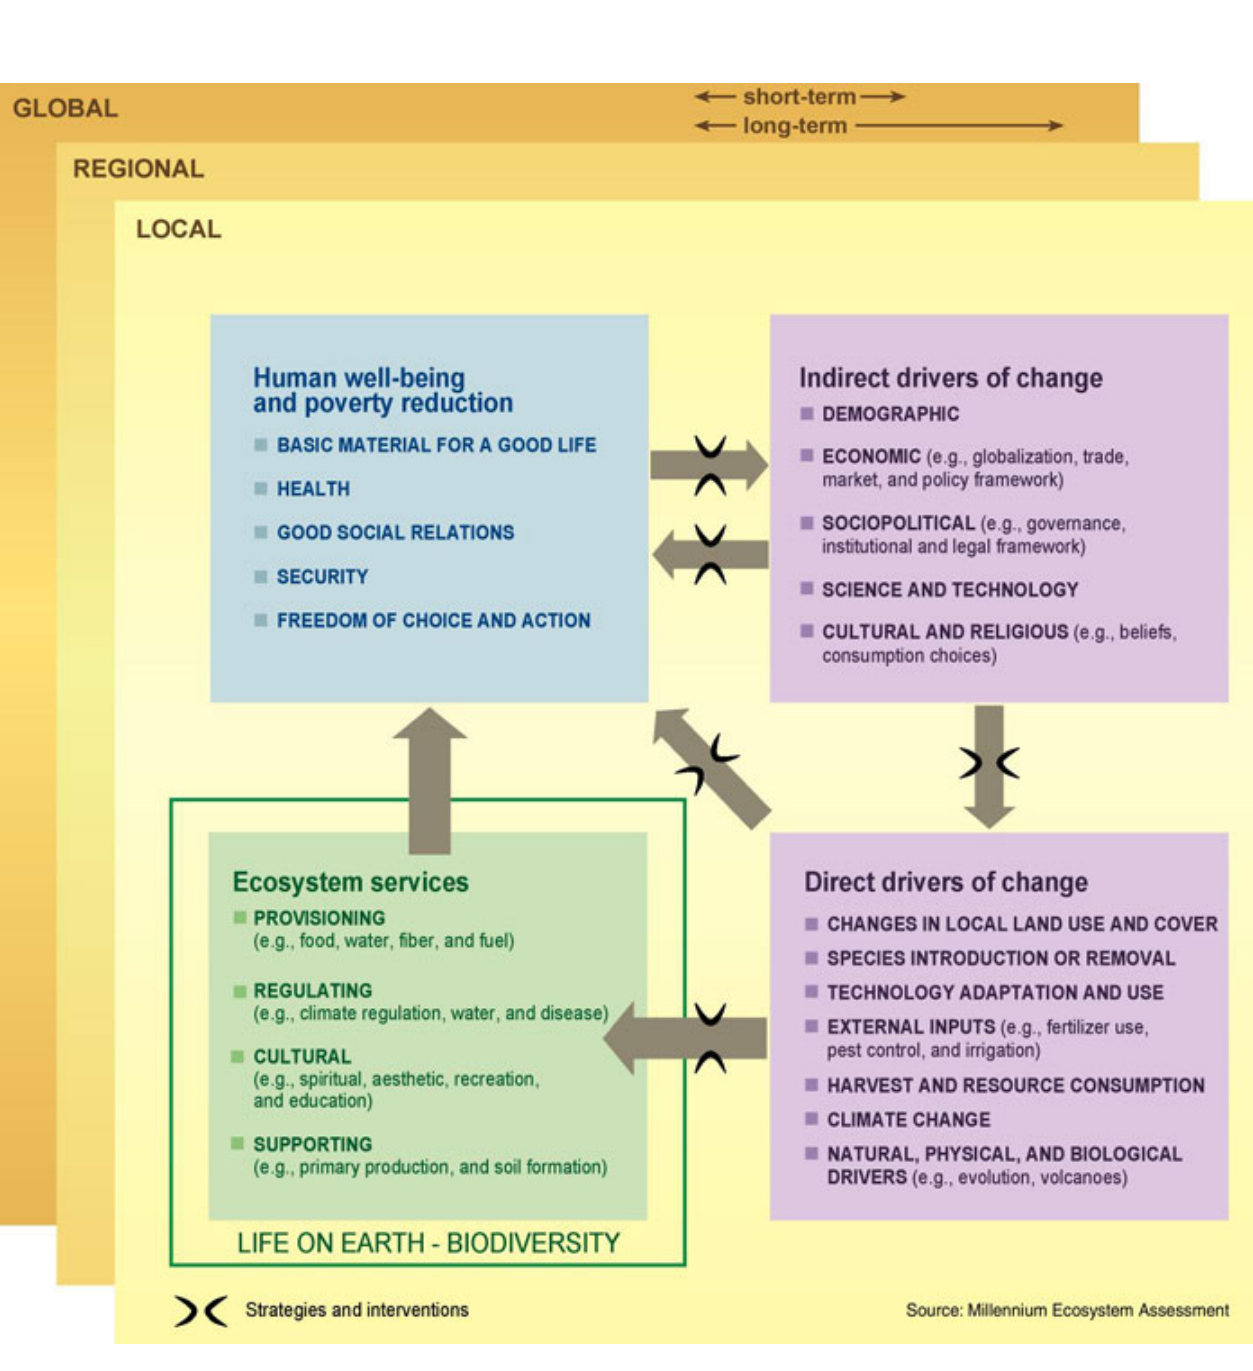
Fig. 1. The MA Conceptual Framework. Source: MA